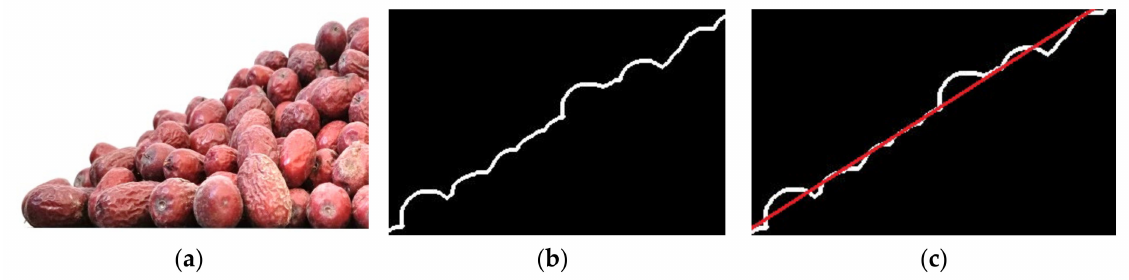
Figure 3. The angle of repose of the fallen jujube fruit (FJF) image processing steps; ( a ) image segmentation, ( b ) boundary extraction, and ( c ) linear fitting of the boundary